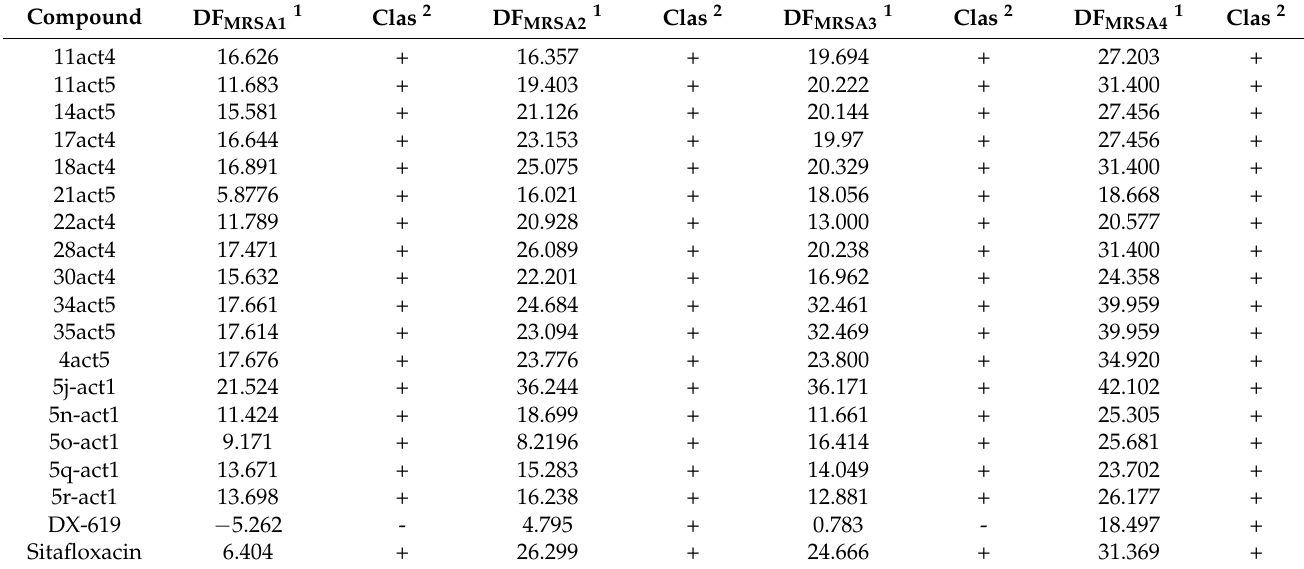
Table 5. Results obtained after combining LDA and PDD for the DFs. Training group: actives.